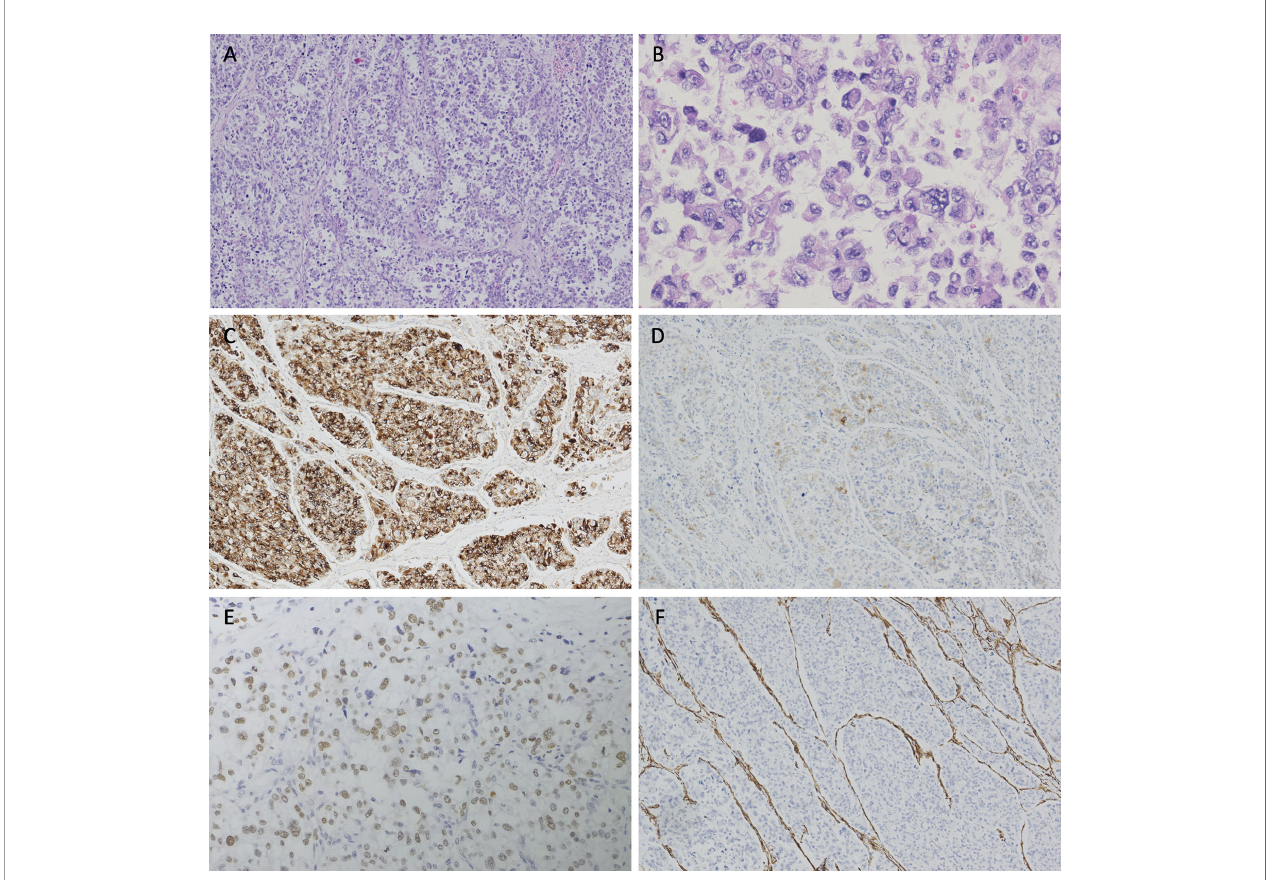
FIGURE 2 | Hematoxylin and eosin (H&E) staining and immunohistochemical analyses of the resected tumor. (A) The tumor cells arrange in a diffuse pattern(×4). (B) Epithelioid tumor cells are oval or polygonal, with clear or granular eosinophilic cytoplasm. Nucleoli are prominent in the vesicular nuclei. Increased mitotic activity and dysplasia are observed (×20). Tumor cells are positive for (C) HMB-45 (strong and diffuse), (D) Melan-A (patchy) and (E) TFE3 (modest and diffuse), and are negative for (F)